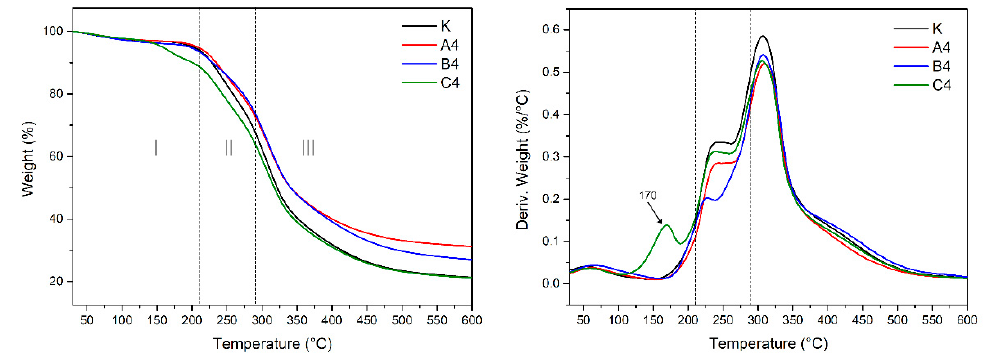
Figure 5. TG and di ff erential TG curves of the di ff erent new-made soy meal samples: K (SM adhesive), Figure 5. TG and differential TG curves of the different new-made soy meal samples: K (SM adhesive), A4 (SM / 5% preservative A), B4 (SM / 5% preservative B), and C4 (SM / 5% preservative A4 (SM/5% preservative A), B4 (SM/5% preservative B), and C4 (SM/5% preservative C).